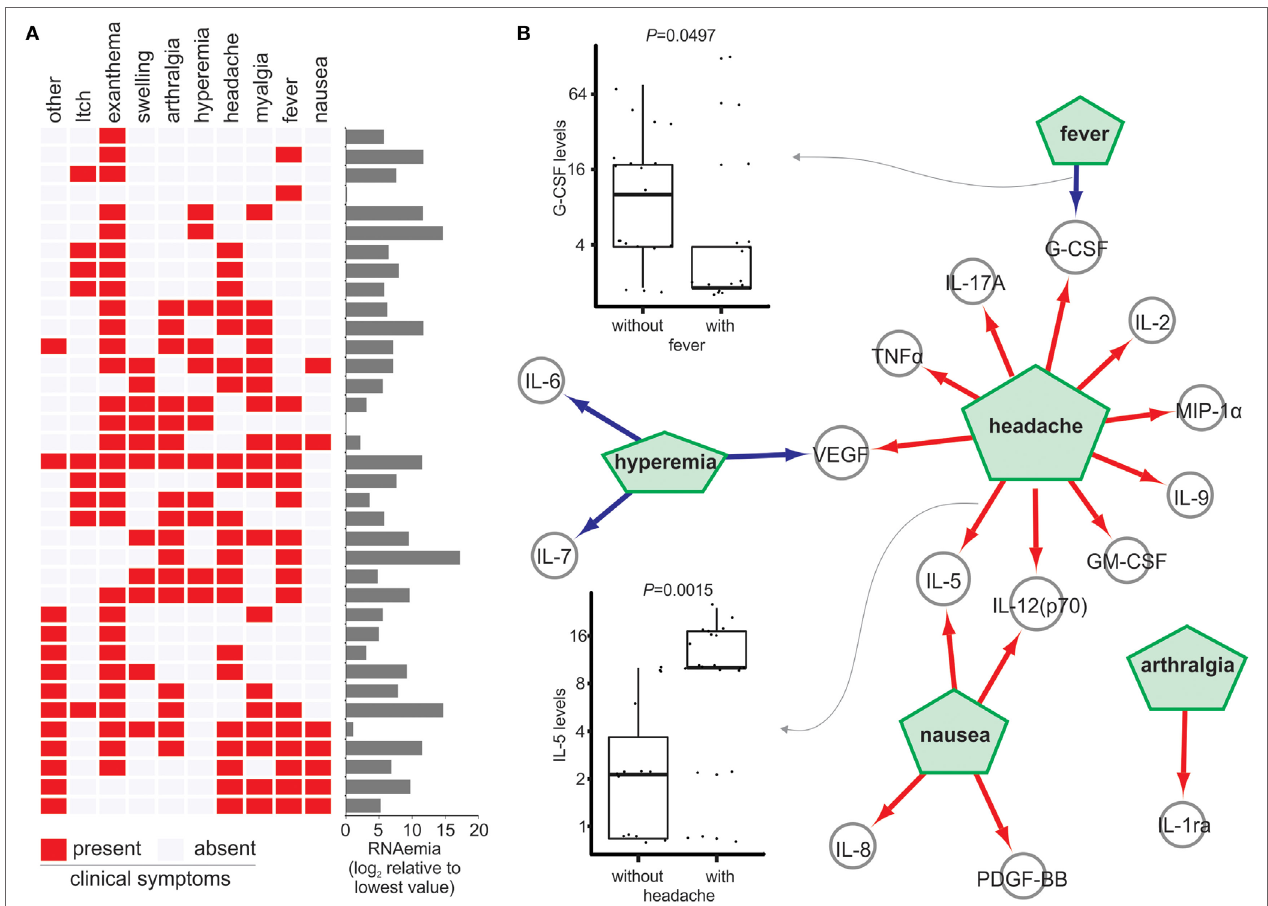
FigUre 4 | Cytokine and chemokine level changes associated with clinical symptoms. (a) Clinical symptoms in Zika virus (ZIKV)­infected subjects. The heat map represents the presence (red) or absence (gray) of symptoms (columns) in ZIKV­infected subjects (rows). RNAemia levels for each subject are shown in the bar graph. (b) Different cytokine levels were associated with different symptoms. The green pentagons represent clinical symptoms and the nodes represent the cytokines and the edges represent putative associations among the pentagons. Red arrows indicate that the level of a given cytokine is higher in ZIKV­infected subjects with the symptoms compared to subjects without them. Blue arrows indicate the cytokine level is lower in patients with the associated symptoms compared to those without them. The box plots show the levels of granulocyte­colony stimulating factor and IL­5 in subjects with fever and headache, respectively. Dots on the graphs represent individuals. p ­Values are indicated at the top of each box